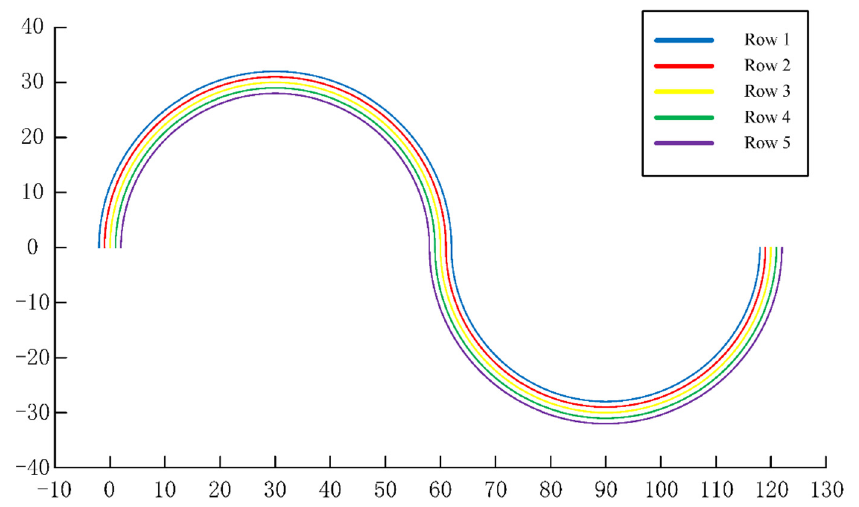
Table 1. Parameters of Tractor and Seeder.